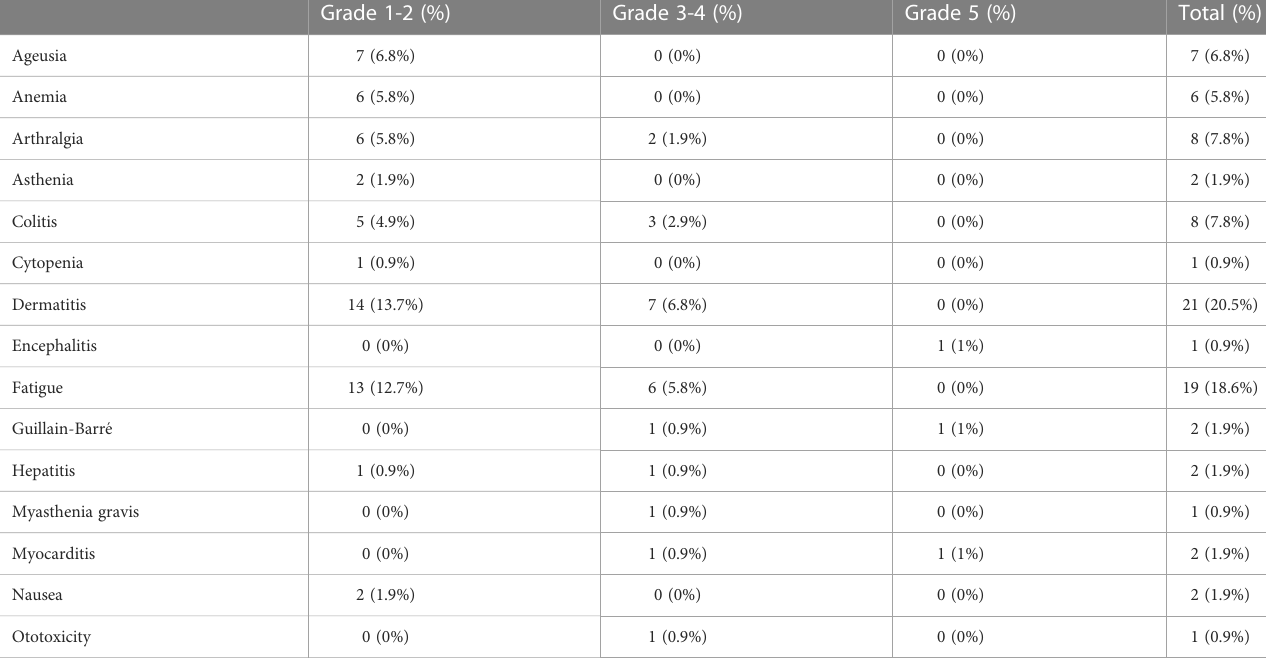
TABLE 3 Adverse event pro fi le of 102 ICI-treated patients with